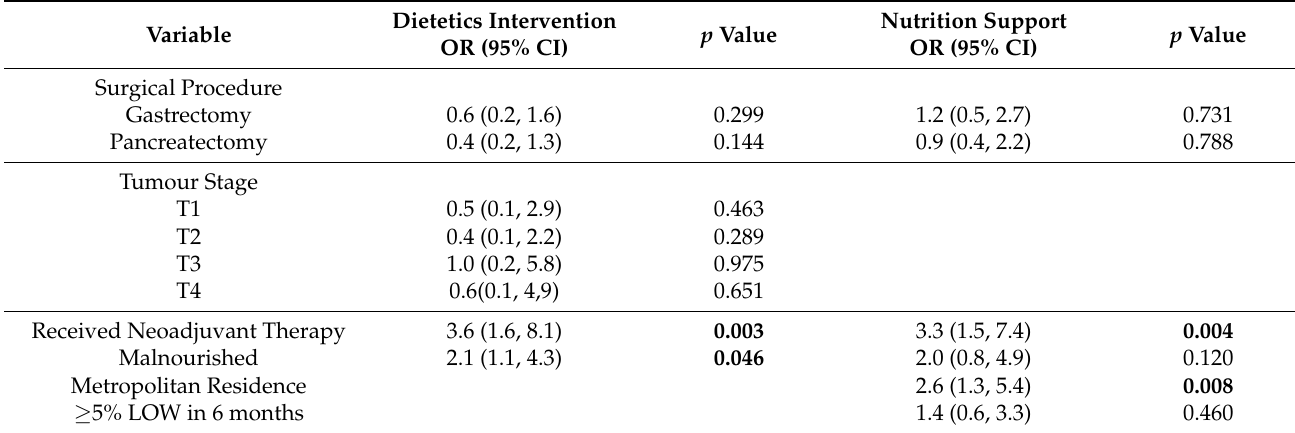
Table 4. Factors independently associated with receiving preoperative dietetics intervention or nutrition support by multivariate analysis.